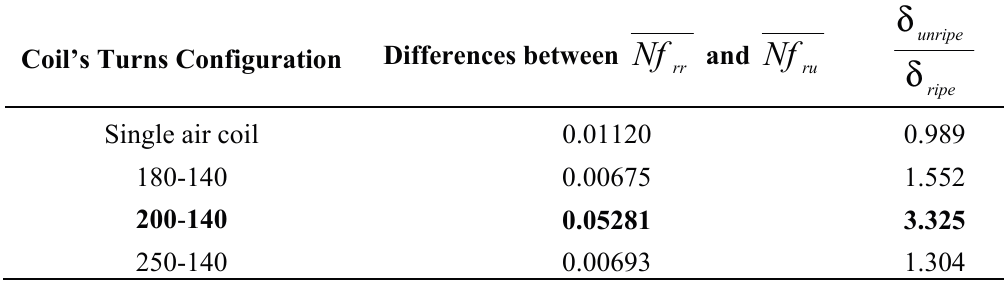
Figure 15. Percentage difference of the comparative analysis with the previous work